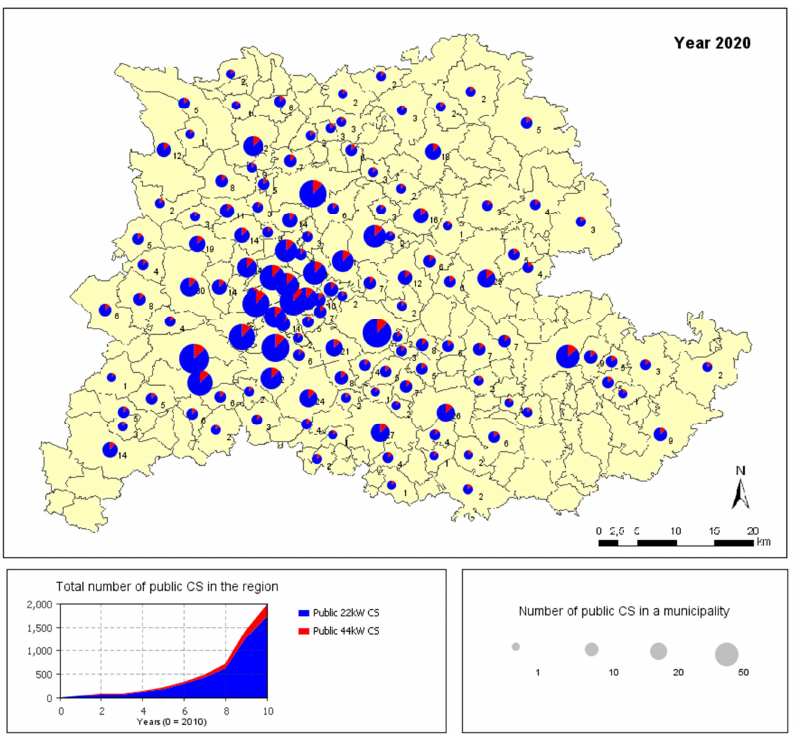
Figure 11. Development of public charging infrastructure until 2020 in the “different spatial usage”